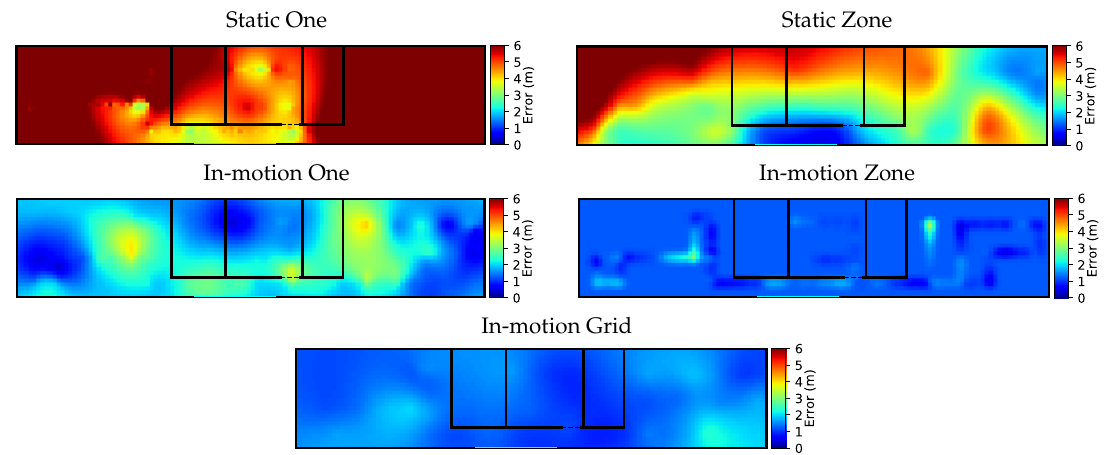
Figure 12. Localization error per calibration procedure in whole